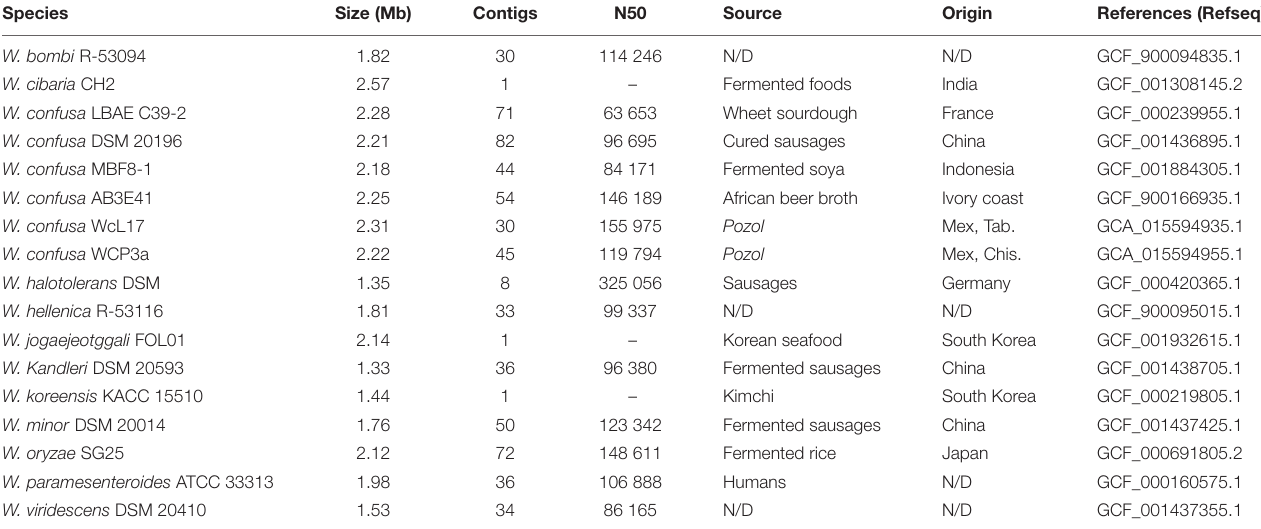
TABLE 1 | Overall properties of representative Weissella genomes sequenced in this work, including W. confusa strains WcL17 and WCP3a. Species Size (Mb) Contigs